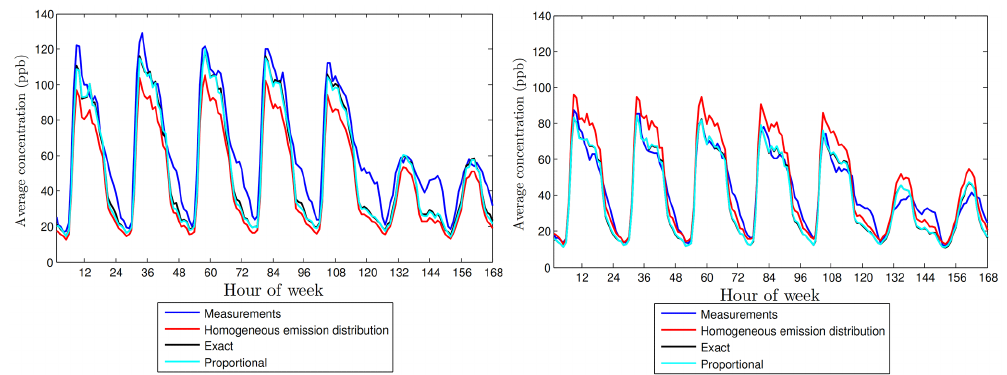
Figure 9. Weekly variation in NO x concentrations for the period 2007–2009 for the north side receptor (left) and the south side recep- tor (right). Where the black curve is not visible it is below the cyan curve.